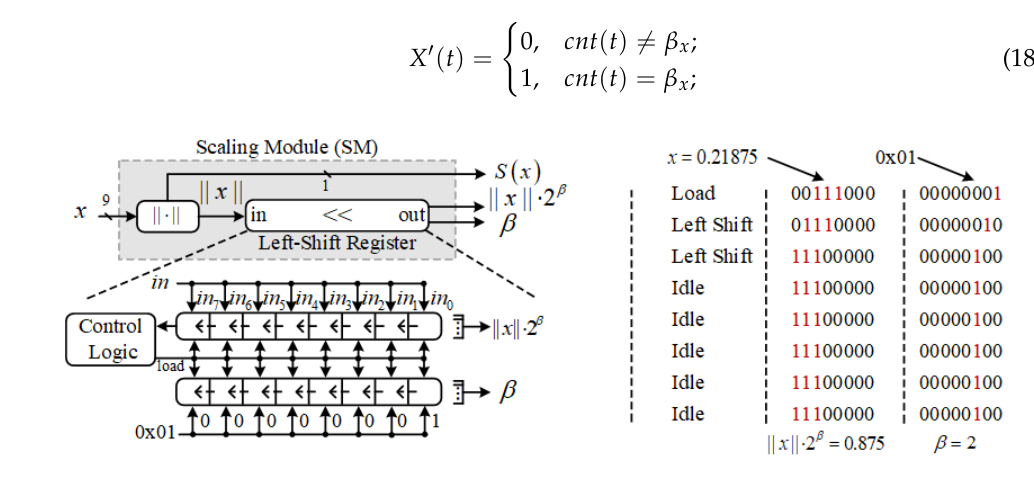
Figure 6. Hardware architecture of scaling modules.